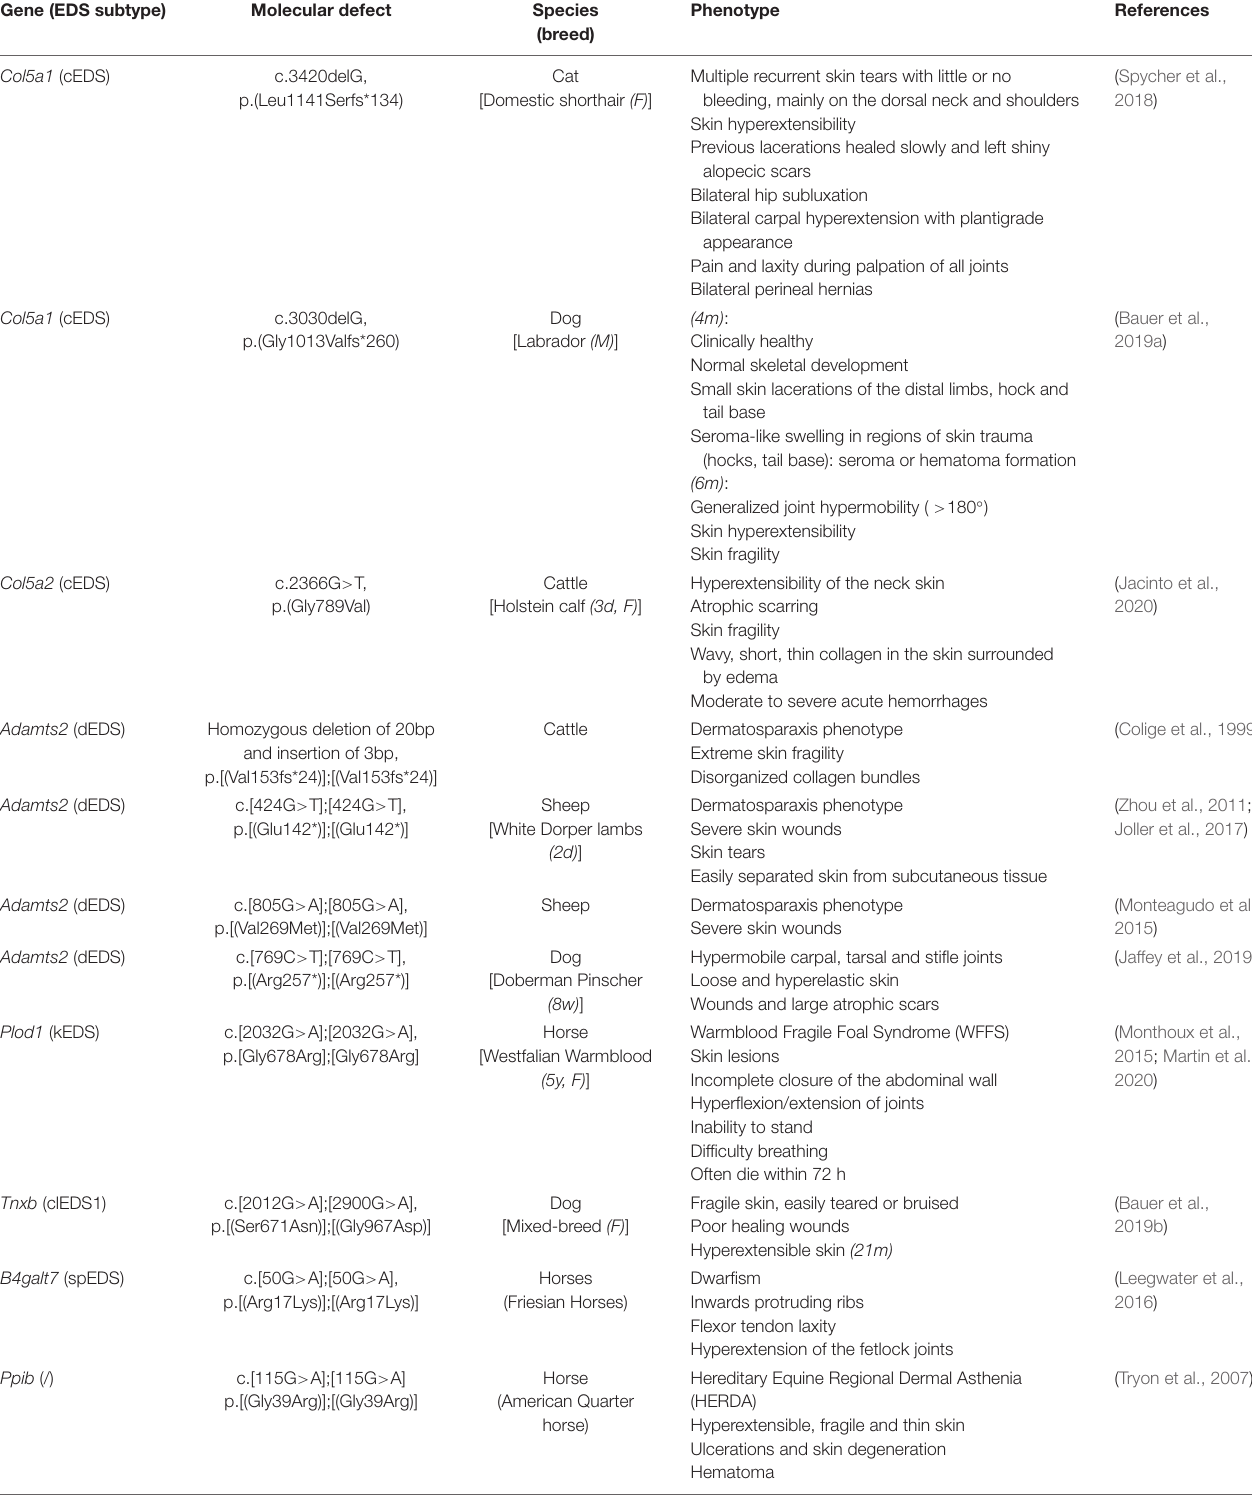
TABLE 2 | Overview of naturally occurring animals with a molecularly proven EDS